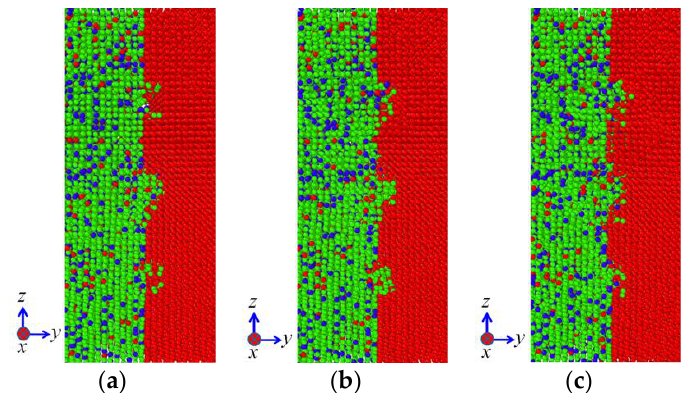
Figure 6. Influence of temperature on the diffusion configuration of model I subjected to the vertical pressure of 50 MPa: ( a ) 1000 K; ( b ) 1200 K; ( c ) 1400 K.